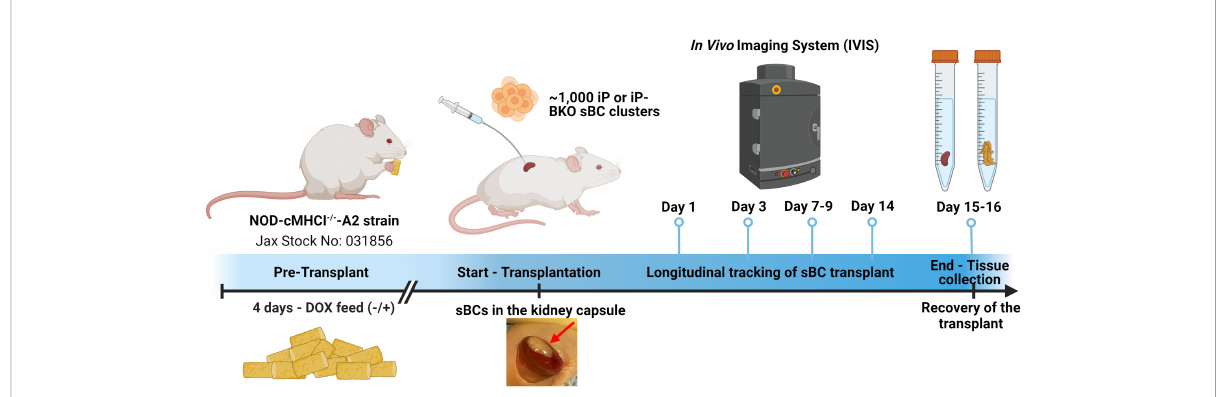
FIGURE 2 Timeline of the study. HLA-A2 and BKO sBC clusters were generated with a Tet-On PD-L1 inducible system (iP) and constitutive luciferase expression. PD-L1 is expressed by the sBC clusters in presence of doxycyline (DOX). Four days prior to transplantation, mice were put on a special diet with doxycycline (+) or maintained on standard diet (-). About 1,000 sBC clusters were transplanted to the left kidney capsule of each mouse. Survival of the transplanted sBCs was monitored by transdermal luminescence detection with IVIS. The sBC graft-bearing kidneys were recovered after completion of the 2-week study period for histology. Created with